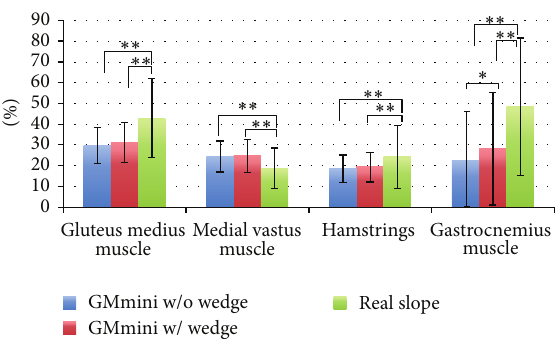
Figure 17: Average muscle activities while ascending a slope.